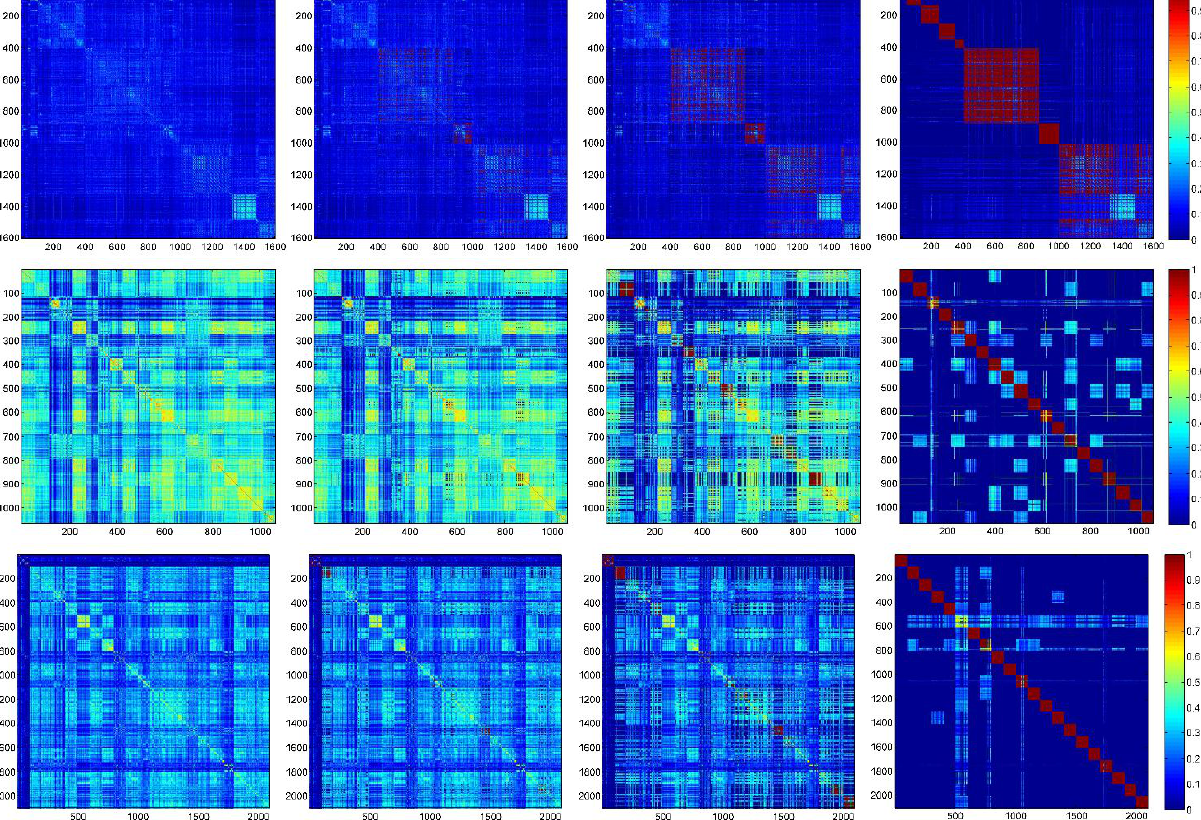
Figure 12. Evaluations of the similarity matrix with the iterative purification of the k -NN graph. From left to right: the similarity matrices after 1, 100, 240 and 500 iterations. From top to bottom: the similarity matrices for the Geo-eye image of Beijing, the WHU-RS dataset, and the UCM dataset. With an increasing number of iterations, the similarity matrices become increasingly